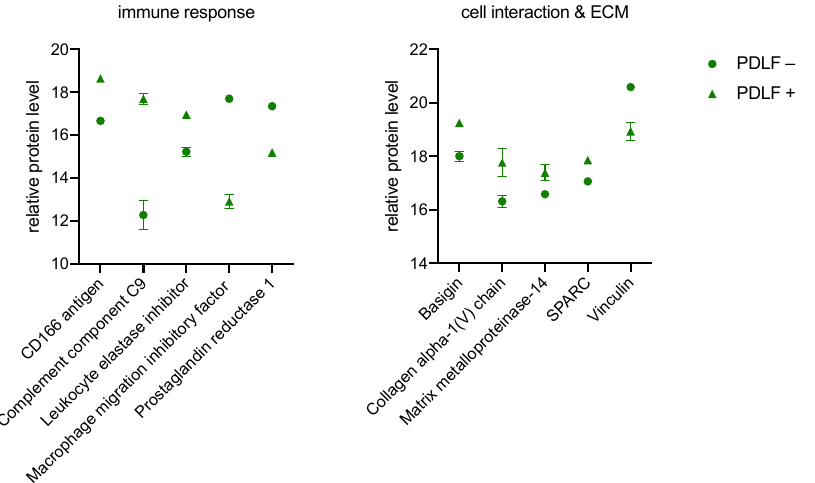
Figure 5. Significant proteins of the immune system ( left ), cell interaction, and ECM ( right ) measured in PDLF. Protein peak areas were transformed with a log2 scale, and bacterial conditions were compared pairwise with standard conditions using a Student’s t -test ( p < 0.05) and Benjamini- Hochberg correction for multiple tests. “+” indicates culture with bacteria; “–” indicates culture without bacteria.